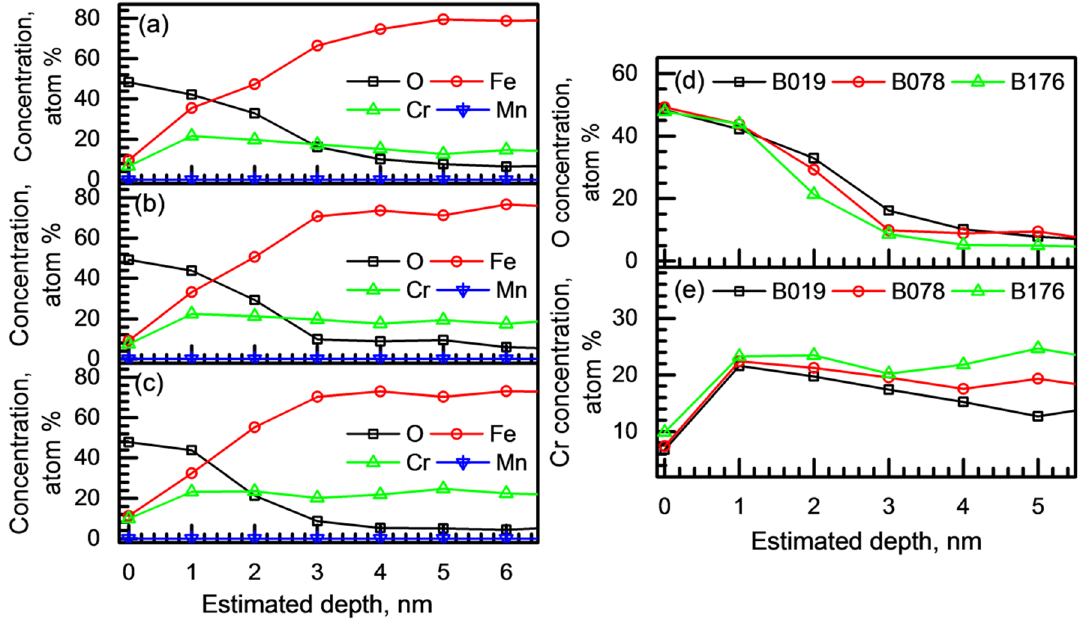
Figure 9. Chemical composition depth profiles of the passive films of ( a ) B019, ( b ) B078, and ( c ) B176 alloys analyzed through XPS; ( d ) O and ( e ) Cr concentration profiles of the passive films formed on the alloys. The passive films were formed in a borate–phosphate–citric buffer solution (pH 8.5) by applying constant anodic potential of 0 V SCE for 3 h.